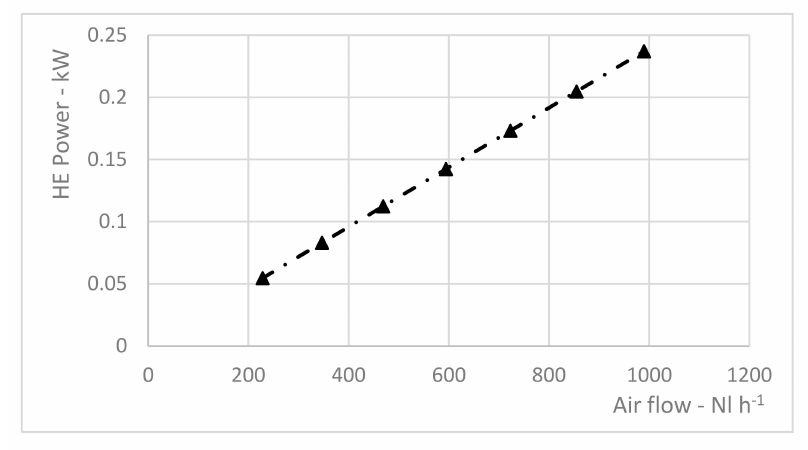
Figure 9. HE sizing as function of the air flow